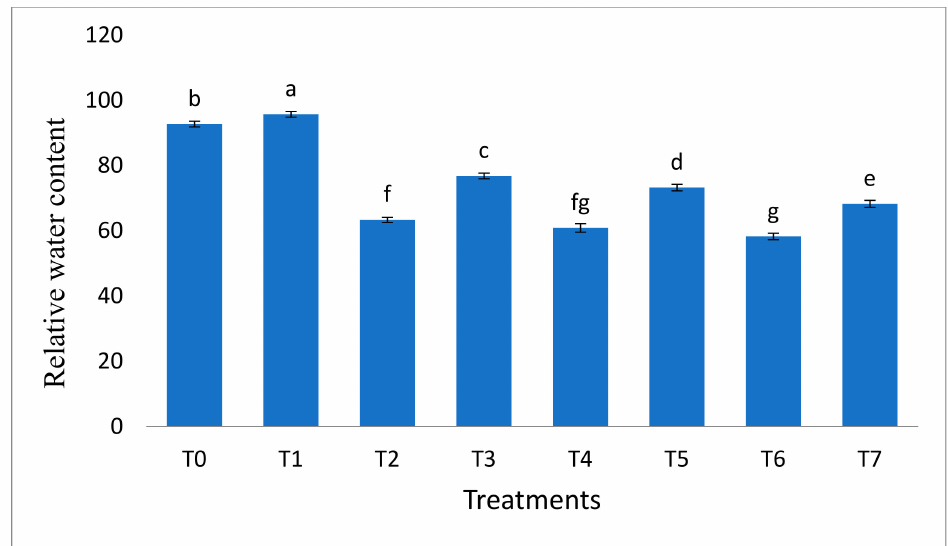
Figure 3. Effect of bacillus inoculation on the relative water content of B. nigra . facing chromium stress. Where T0 = Control, T1 = B. cereus , T2 = Cr-20 mg/kg, T3 = Cr-20 mg/kg + B. cereus , T4 = Cr-30 mg/kg, T5 = Cr-30 mg/kg + B. cereus , T6 = Cr- 40 mg/kg, T7 = Cr-40 mg/kg + B. cereus . Mean and standard deviations are shown in the figure. Different letters indicate significant differences between means of treatments at p < 0.05 according to the LSD test.